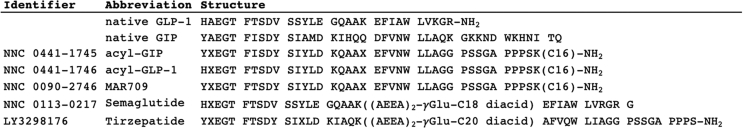
Structure and identifiers of GLP-1 and GIP mono- and dual-agonists. Amino acid sequence, in-paper abbreviations, and external identifiers of the GLP-1 and GIP-derived compounds used.